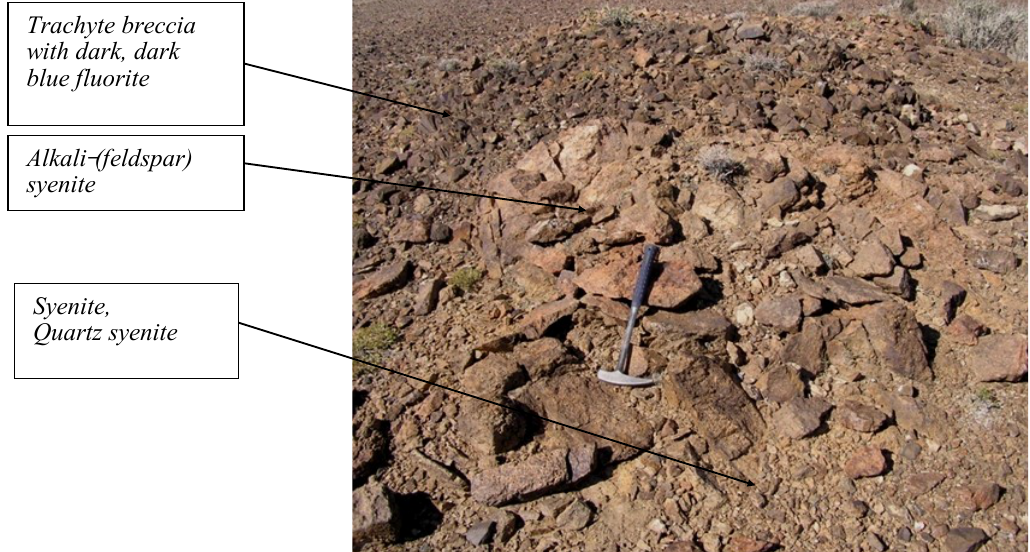
Fig. 3. Outcrop view of the breccia pipe (8.5 x 17 m)